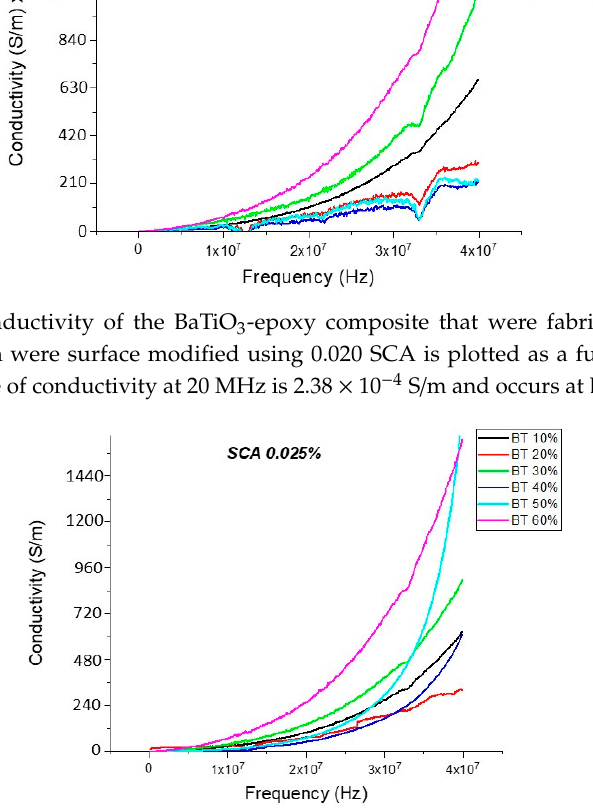
Figure 23. The conductivity of the BaTiO 3 -epoxy composite that were fabricated using BaTiO 3 nanoparticles which were surface modified using 0.025 SCA is plotted as a function of frequency. The maximum value of conductivity at 20 MHz is 2.58 × 10 − 4 S/m and occurs at BT 0.6.